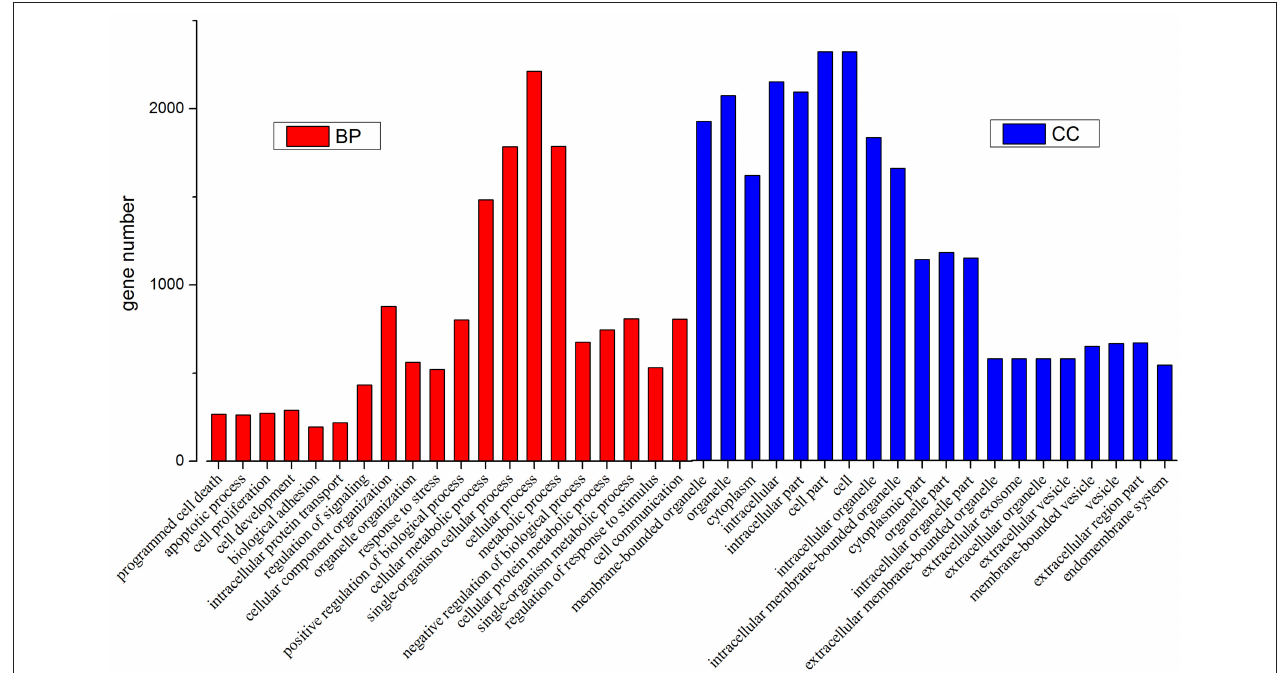
FIGURE 8 | GO analysis of all the differentially expressed target genes of